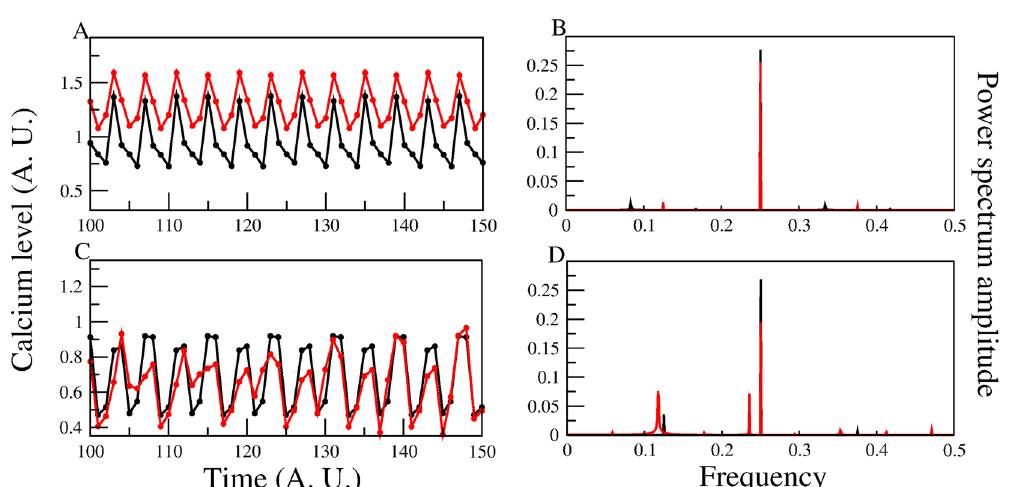
Figure 6. [ Ca 2 + ] i dynamics of the network model with and without the CaKC channel for Models II and III. In panel A for Model-II the [ Ca 2 + ] i node dynamics with all nodes present is shown in black and without the CaKC channel in red. Notice the higher calcium concentration in the red curve. A longer period for the WT is manifest in panel B by the appearance of an additional lower frequency Fourier mode. For panels (C) and (D), the Model-III calcium dynamics shows a decrease in the calcium level (as observed in the experiments with Iberiotoxin) 16 as well as a more elaborate temporal behaviour in the Fourier power spectrum with the appearance of a longer period component not present in the WT case (also observed in the mentioned